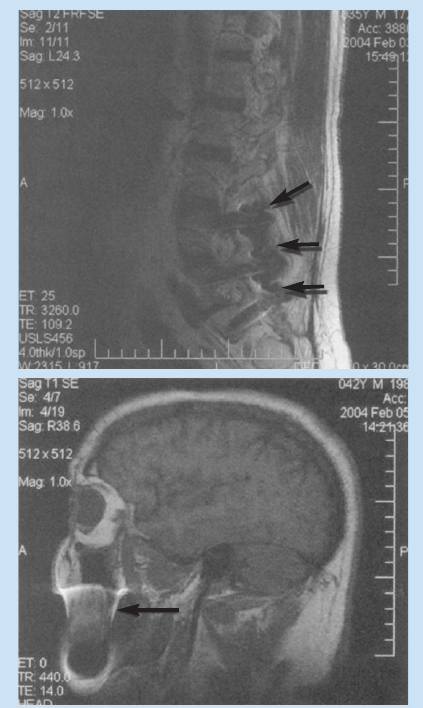
Figs 3 and 4. Metal-related artefacts.